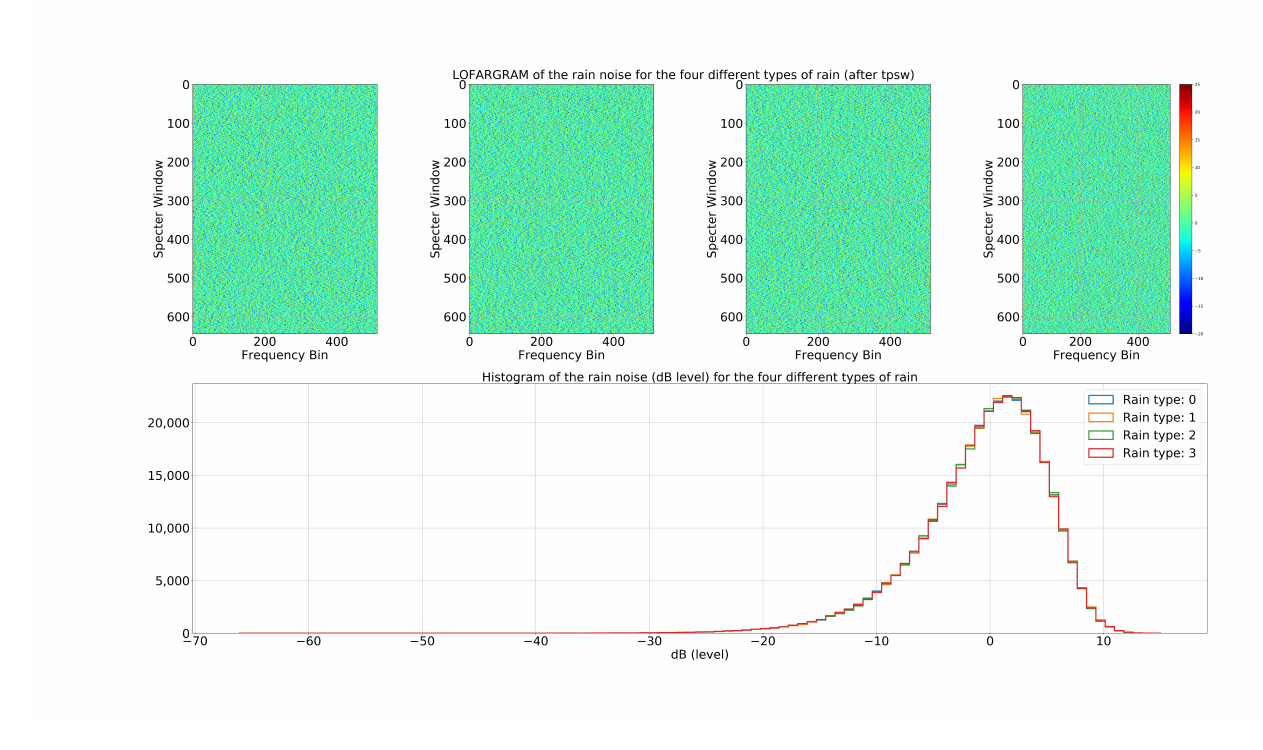
Figure 17. LOFARGRAMs of the rain noise, for the four possible configurations, without ( a ) and with ( b ) the application of the TPSW preprocessing step. The rain noise rises with its level.